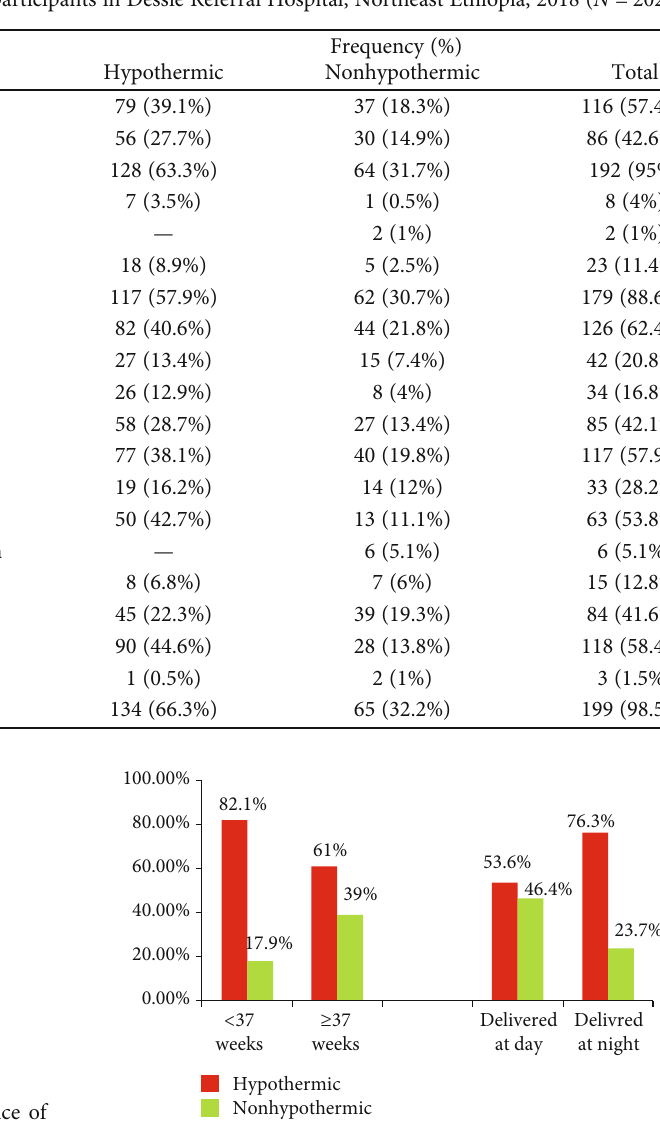
Figure 3: Comparison of hypothermia with gestational age and time of delivery in Dessie Referral Hospital, Northeast Ethiopia, 2018 ( N = 202